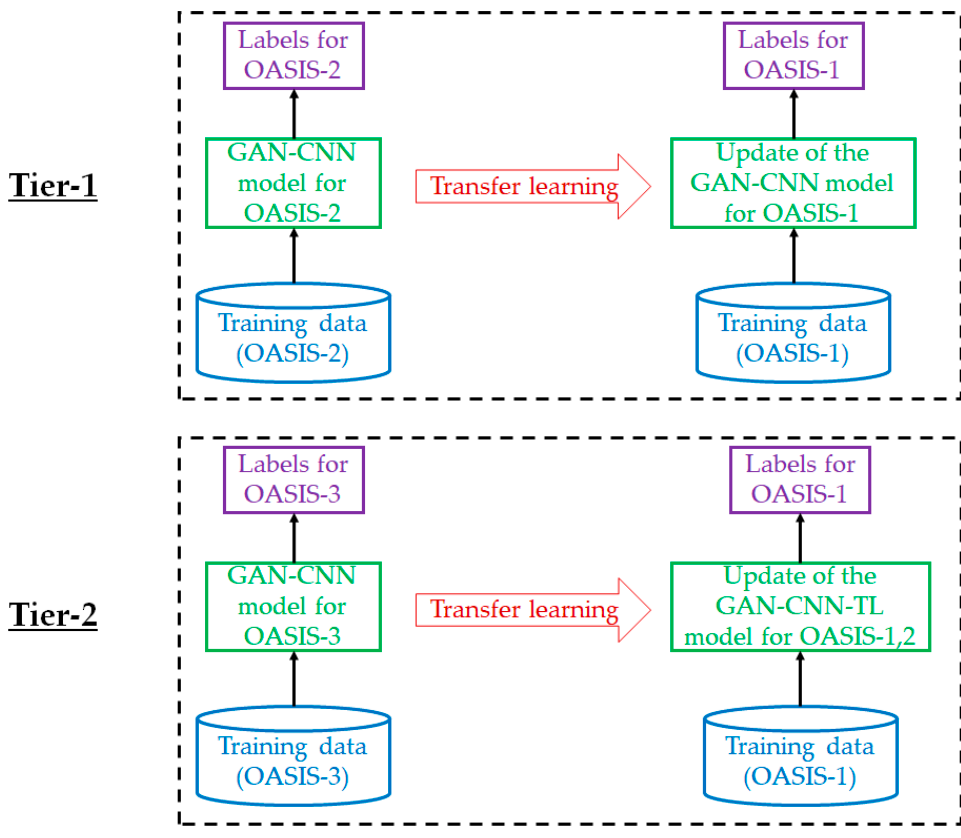
Figure 4. Two-tier transfer learning process with domain knowledge transfer to model for OASIS-1 by OASIS-2 and OASIS-3.